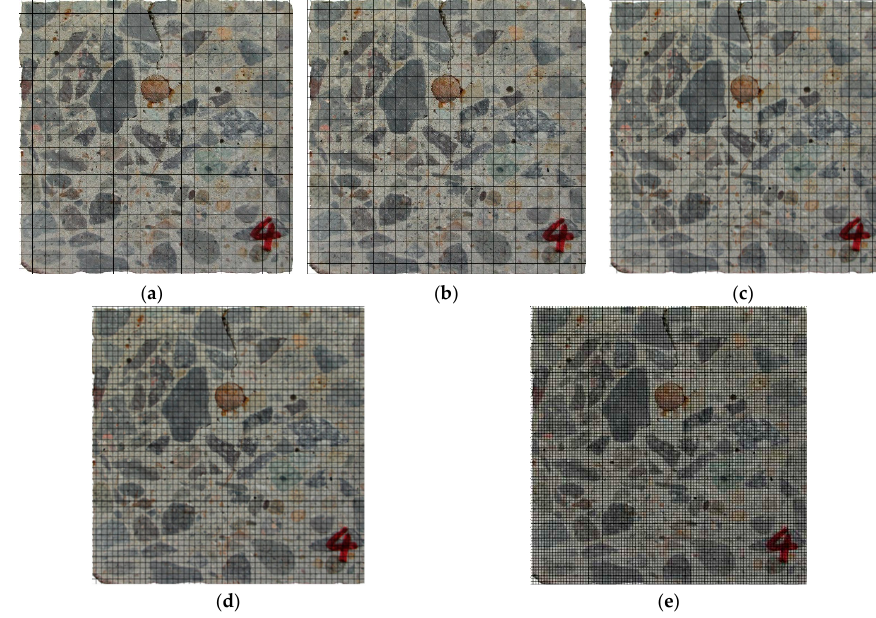
Figure 4. Meshing of digital pictures with different scale distances: ( a ) r = 5 mm; ( b ) r = 4 mm; ( c ) r = 3 mm; ( d ) r = 2 mm; ( e ) r = 1 mm.